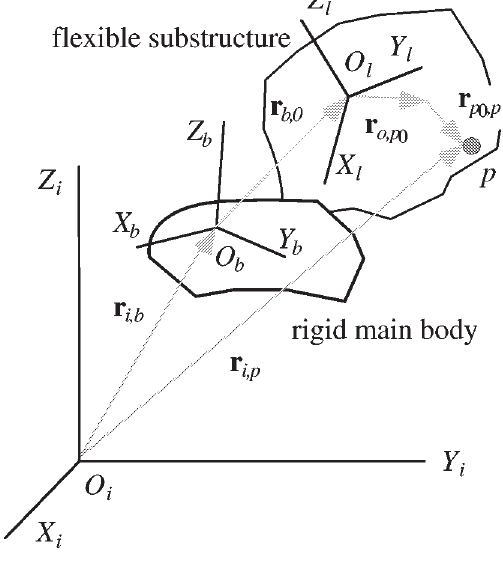
Fig. 4. Particle p in a flexible